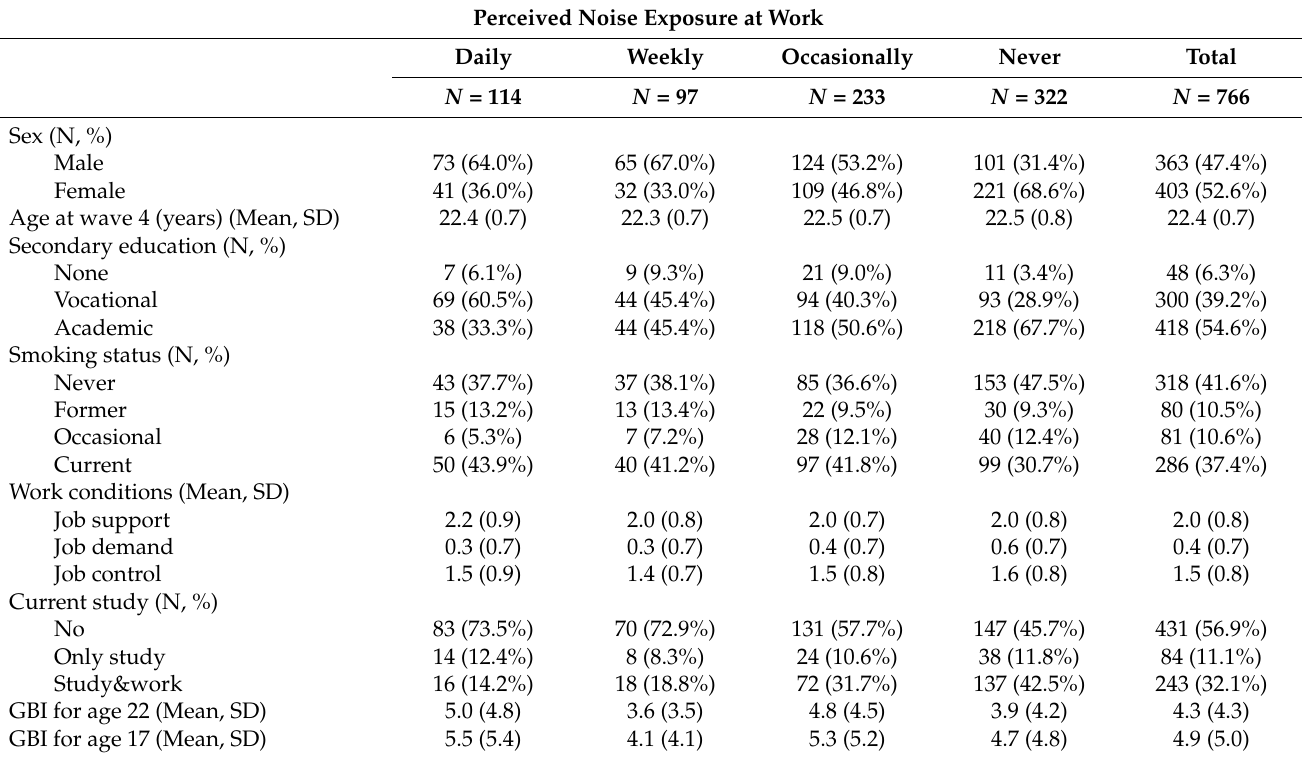
Table 1. Distributions of variables (outcomes and covariates) by noise exposure categories in young adulthood among participants who had worked at least weekly in the prior 12 months.